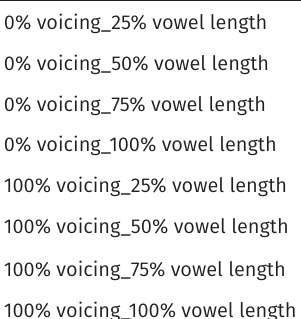
Table 3: Manipulated patterns tested in Experiment